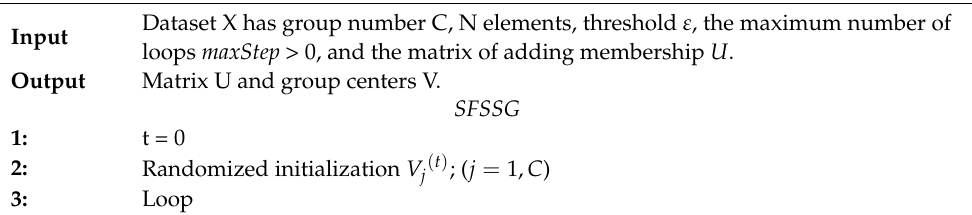
Algorithm 1 The standard fuzzy semi-supervised grouping